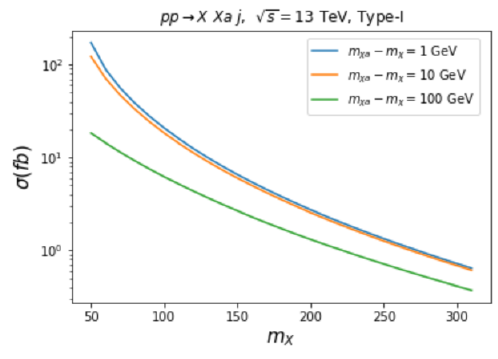
Figure 5 . Cross sections for mono jet production j(cid:31)(cid:31) as a function of DM mass for the benchmark points presented in table 2. The mass squared parameter m 2 coupling (cid:21) abc remained (cid:12)xed as displayed on the table.